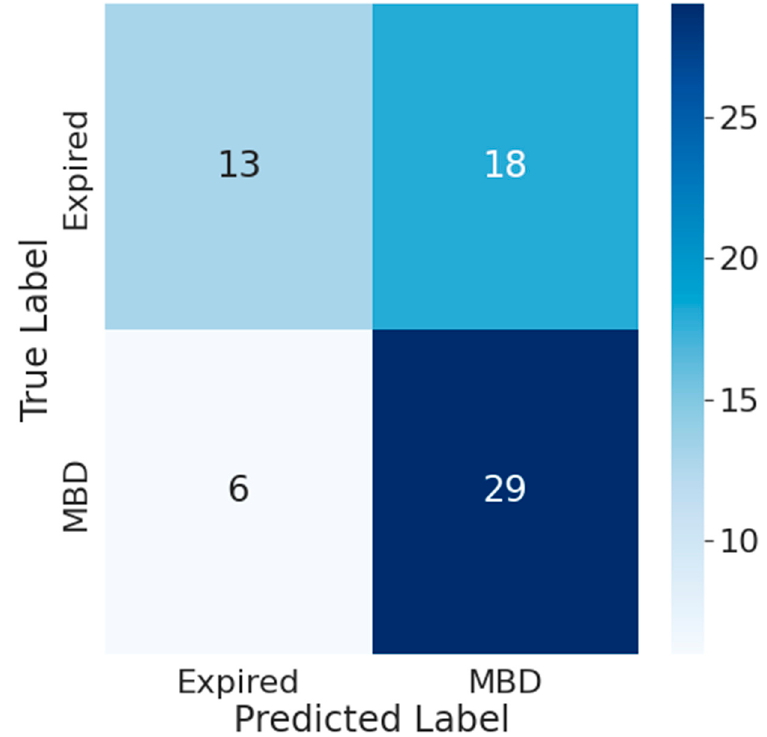
Figure A11. BiLSTM model confusion matrix using the wearable data.